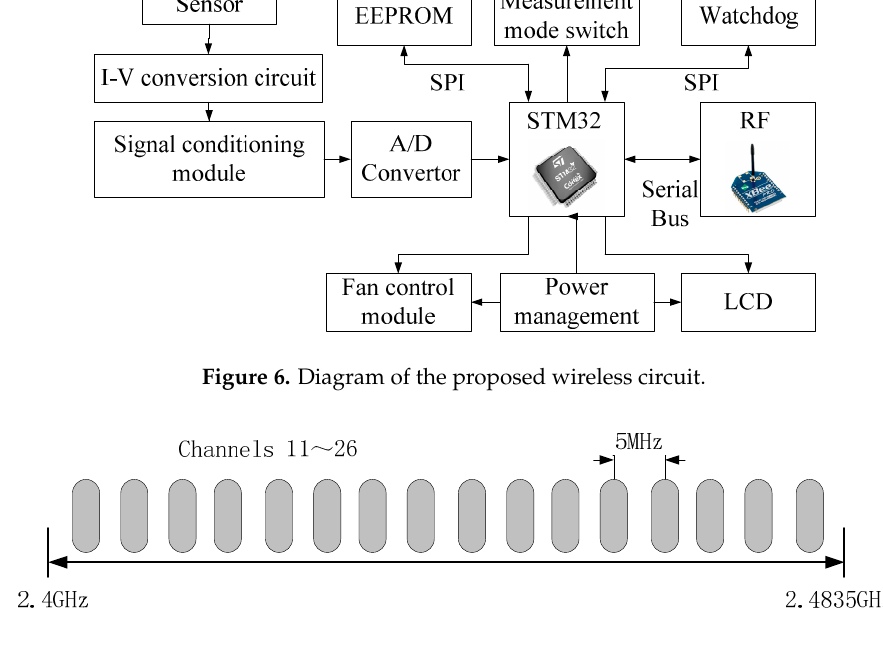
Figure 7. The channels distribution of Zigbee in the 2.4 GHz band.